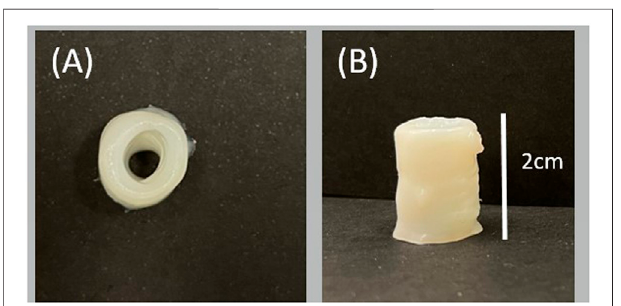
FIGURE9 | 3D tubular structureprinted withDN25 using REGEMAT 3D BIO V1: (A) top view and (B) side